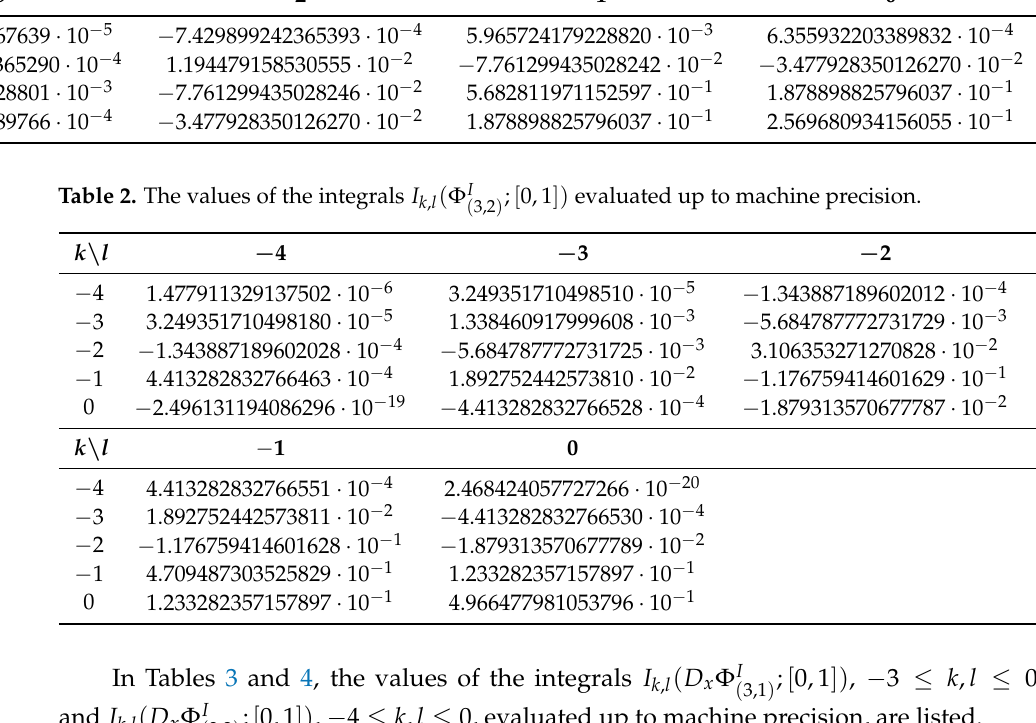
; [ 0,1 ]) evaluated up to machine precision. ( 3,1 )